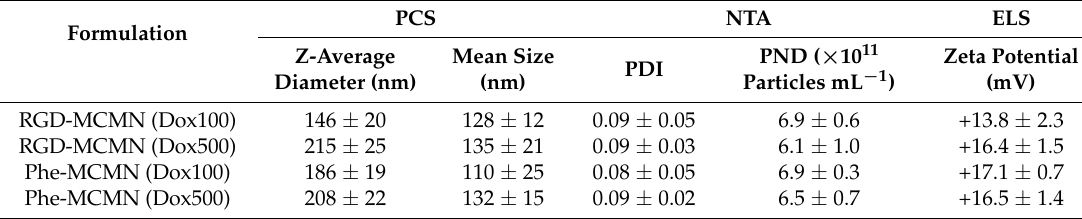
Table 1. Physicochemical characterization of formulations containing Doxorubicin by photon correlation spectroscopy (PCS), nanoparticle tracking analysis (NTA) and electrophoretic light scattering (ELS) (mean ± SD).